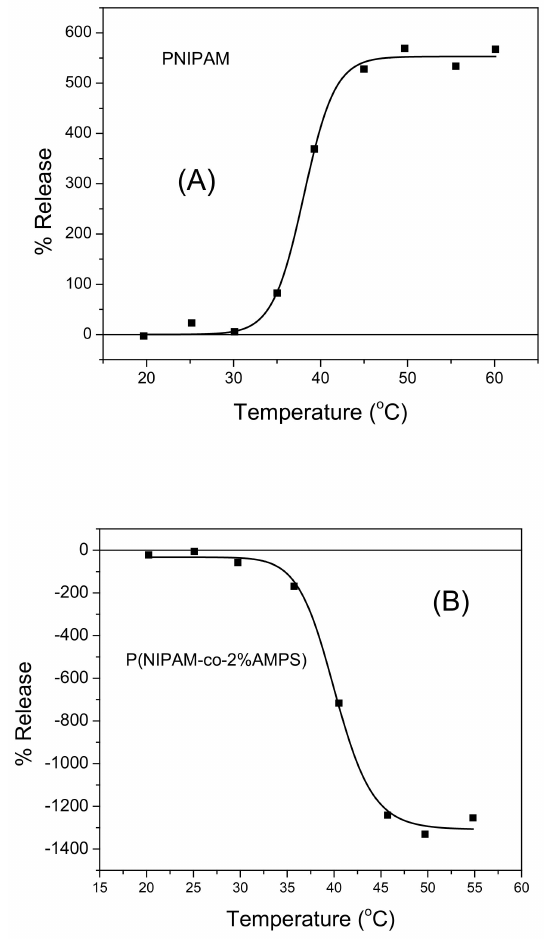
Figure 7. Rubipy release (measured by spectrophotometry in the solution side) from gels at different temperatures. ( A ) PNIPAM. ( B )